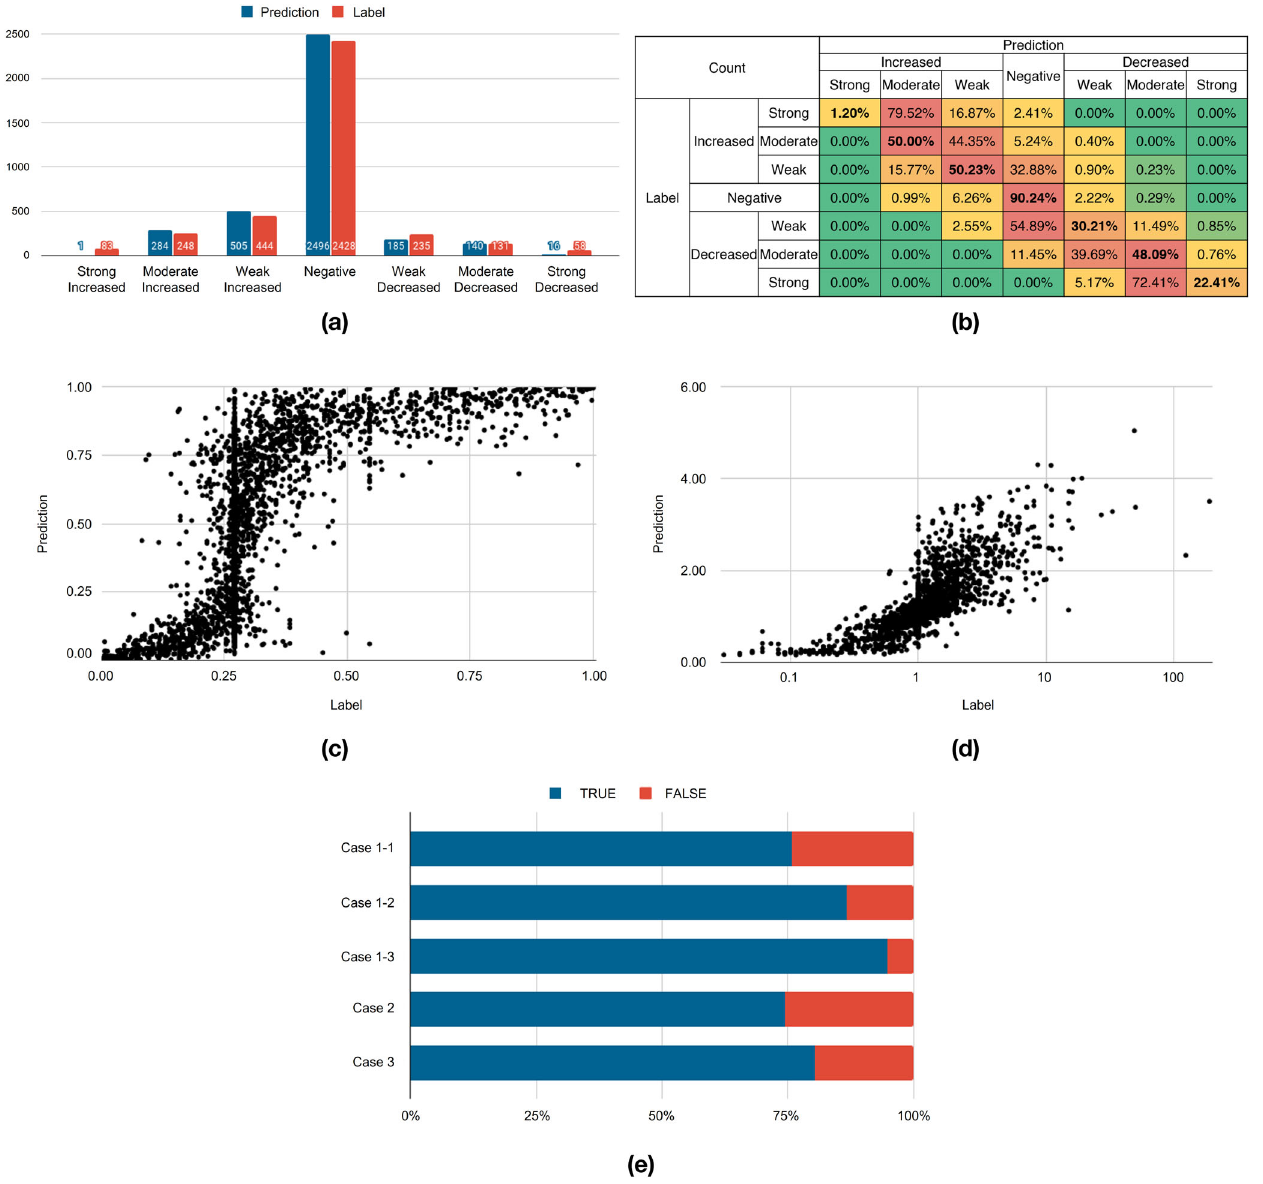
Fig. 2 Model performance. a Distribution of predicted and labeled drug-drug interactions (DDIs) according to the Food and Drug Administration ’ s (FDA) classi fi cation criteria. A strong DDI means that the perpetrator drug increases the area under the time-concentration curve (AUC) of the victim drug by more than 5-fold or decreases the AUC to less than 0.2-fold. In moderate DDI, the perpetrator increases the victim drug AUC by 2- to 5-fold or decreases the victim drug AUC by 0.2 to 0.5-fold. When weak DDI occurs, the perpetrator increases the victim drug AUC by 1.25- to 2-fold or decreases it by 0.5- to 0.8-fold. The AUC fold change (FC) between 0.8- and 1.25-fold, which does not belong to any criteria, is de fi ned as a negative DDI. b Heatmap for the predicted percentage of DDI classes correctly called among each DDI class in the label. Cells with higher percentages are colored red for each prediction class. c Percentage rank of a given value in a data set. d Scatter chart. e Evaluation for quantitative AUC FC. Case 1-1: {0.8 × FC lab ≤ FC pre } ∧ {1.25 × FC lab ≥ FC pre }. Case 1-2: {0.67 × FC lab ≤ FC pre } ∧ {1.5